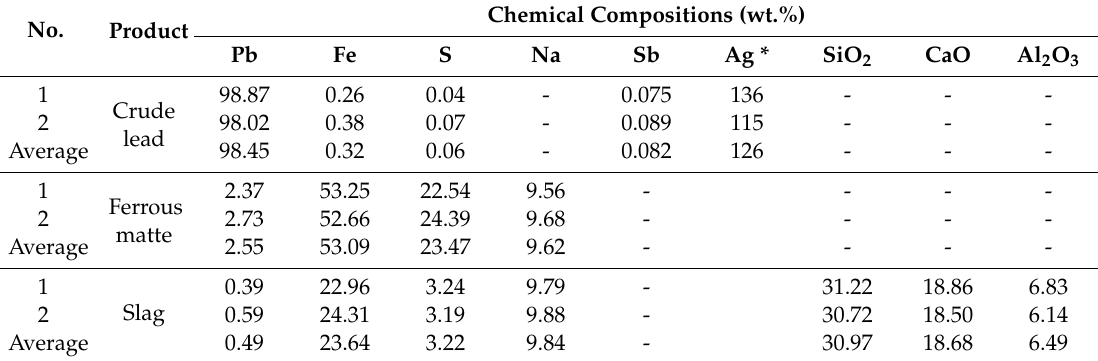
Table 2. Chemical compositions of recycling products in the comprehensive expansion experiments (wt.%), * g /